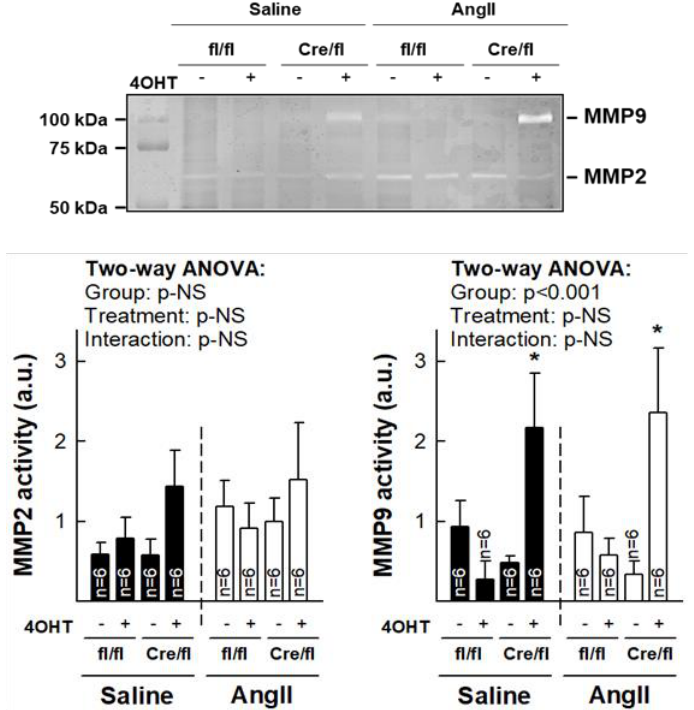
Figure 5. Normalization of collagen deposition in Cx43 Cre-ER(T) / fl mice treated with 4-OHT and infused with AngII correlates with increased MMP9 activity. Representative gelatin zymography (upper panel) showing MMP2 and MMP9 enzymatic activity in myocardial samples from saline- and AngII-treated Cx43 fl / fl (fl / fl) and Cx43 Cre-ER(T) / fl (Cre / fl) mice. Lower panels show mean quantification of 6 di ff erent experiments. * ( p < 0.05) indicates significant di ff erences vs. corresponding the Cx43 fl / fl + oil group.